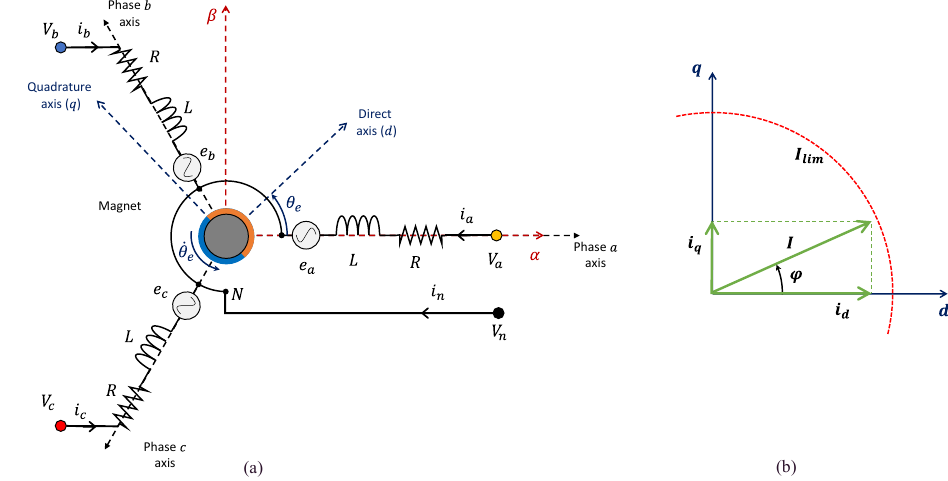
Figure 4. ( a ) Three-phase PMSM schematics (one pole pair); ( b ) current phasor in Park plane.